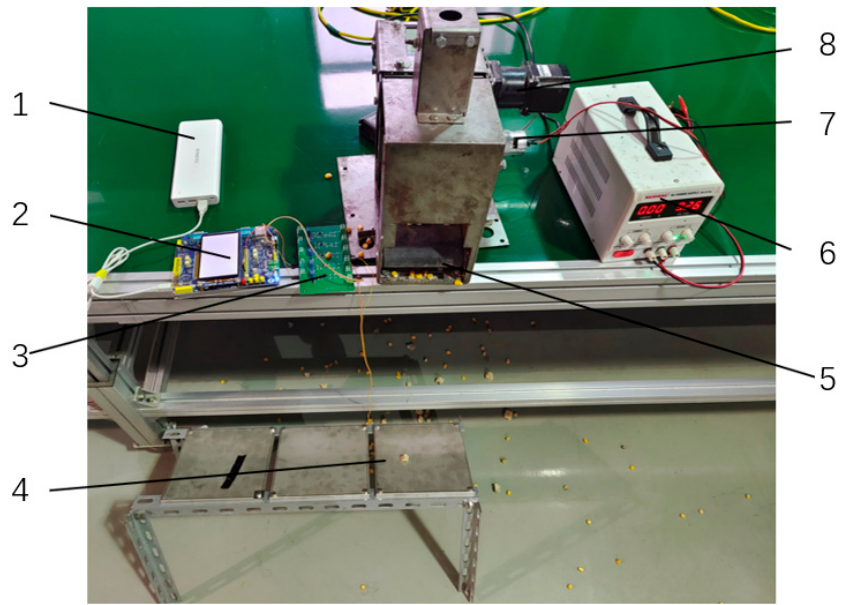
Figure 10. Test device: 1—5V DC power supply; 2—microprocessor; 3—signal processing circuit; 4—sensitive plate; 5—conveyor belt; 6—adjustable DC power supply; 7—DC motor1; 8—DC mo-